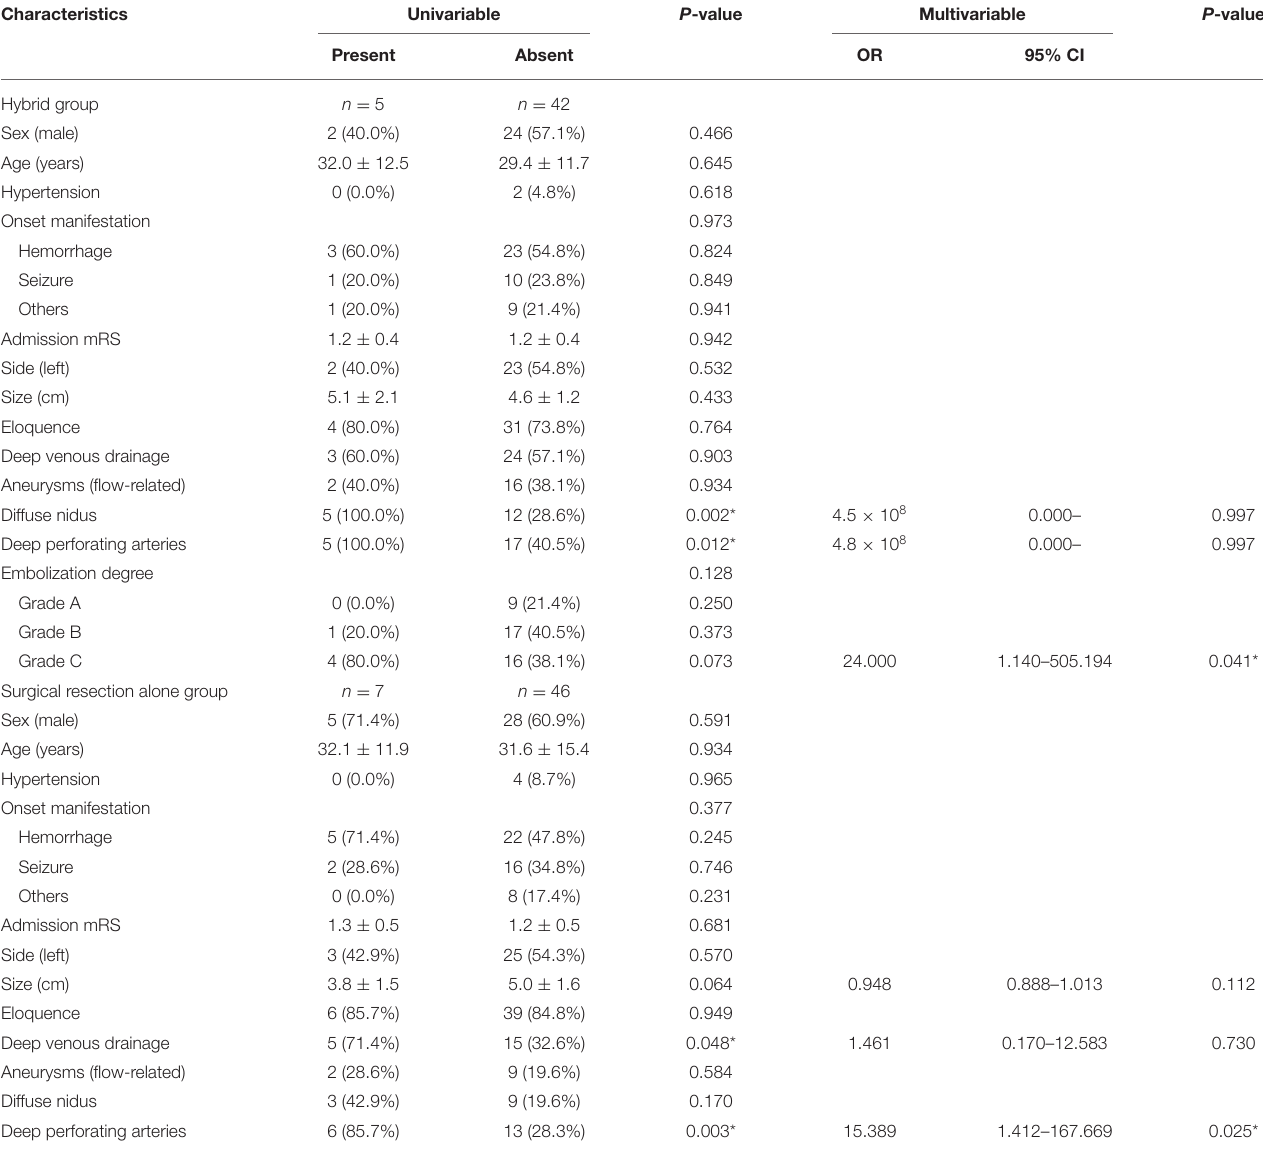
TABLE 3 | Risk factor analysis of long-term disability (mRS > 2) in the whole AVM cohorts. Characteristics Univariable P -value